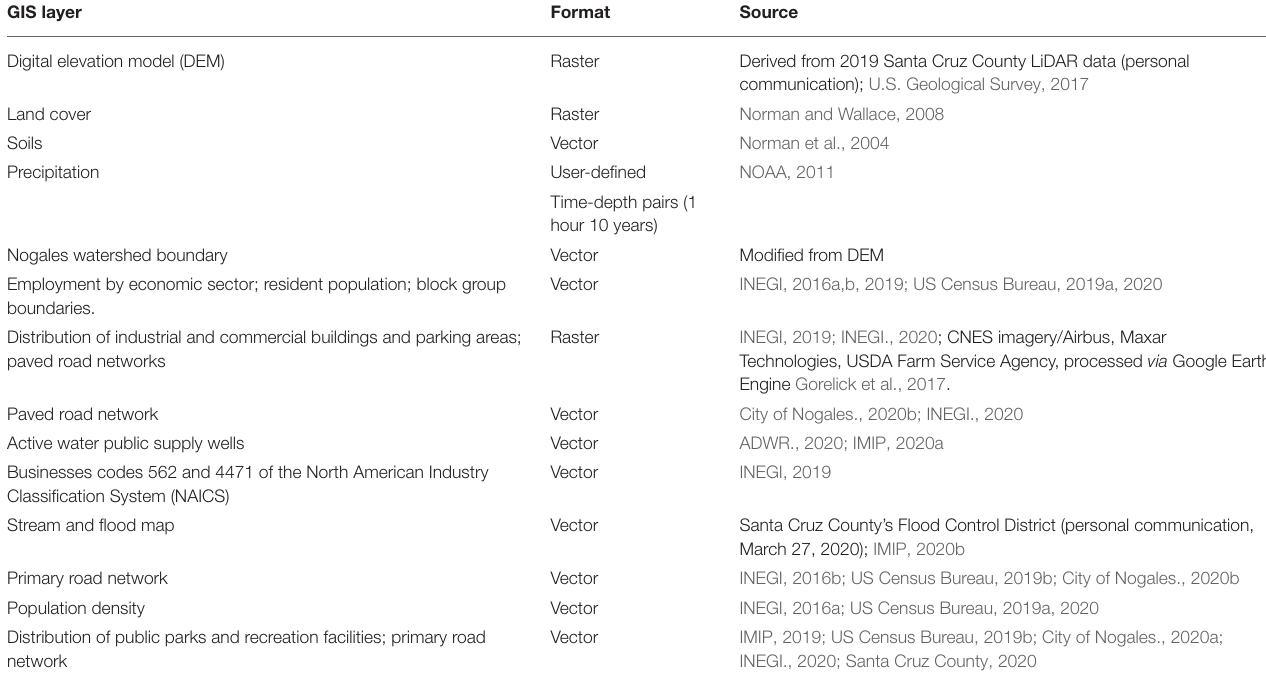
TABLE 1 | Data types and sources used in